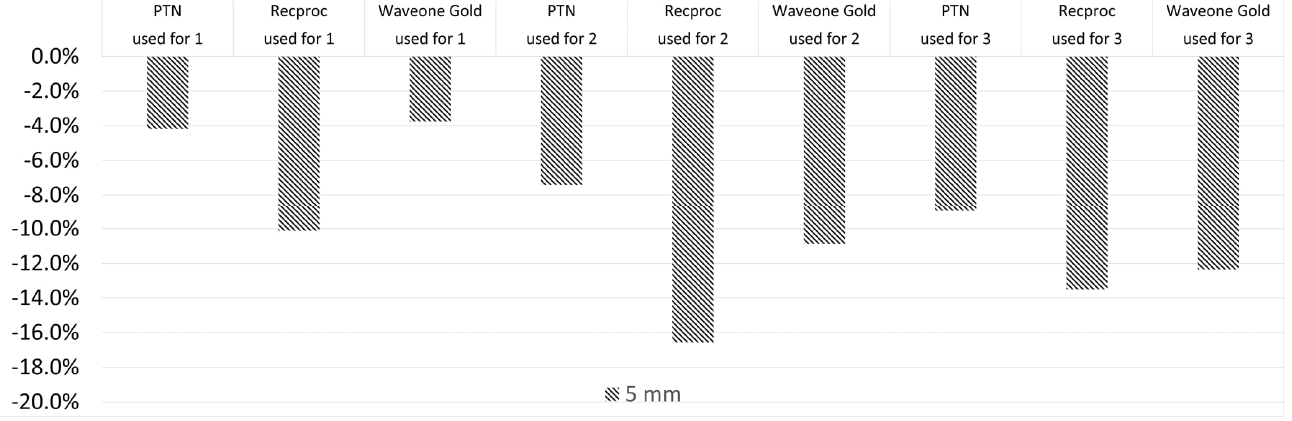
Figure 4. Comparison of the average wear values of the files were measured at 5th millimeter from the apical compared to the file that was never used between different file systems.